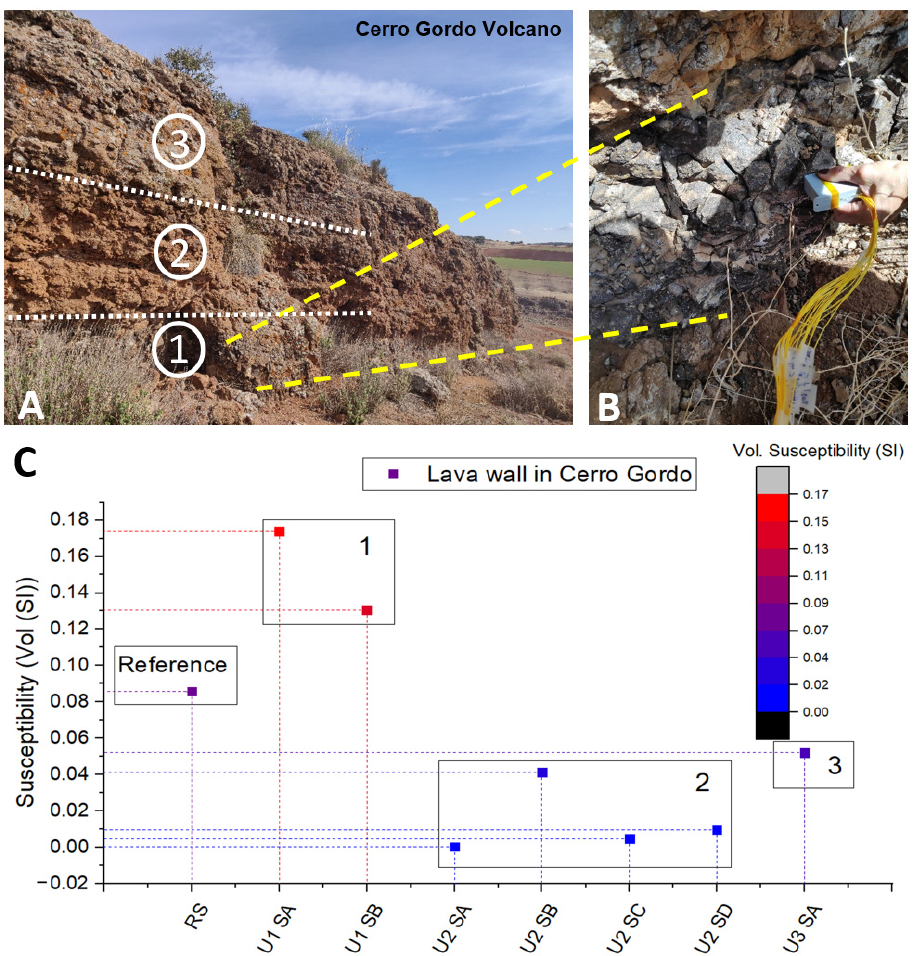
Figure 13. ( A ) Photograph of the spatter deposit wall. ( B ) NEWTON instrument measuring the susceptibility of the rocks of the layer. ( C ) Magnetic susceptibility of the different layers depicted in A as well as a reference sample: an epoxy parallelepiped with 10% weight of ferrite in the SI. The NRM of several samples ranges from 5 up to 40 Am − 1 .